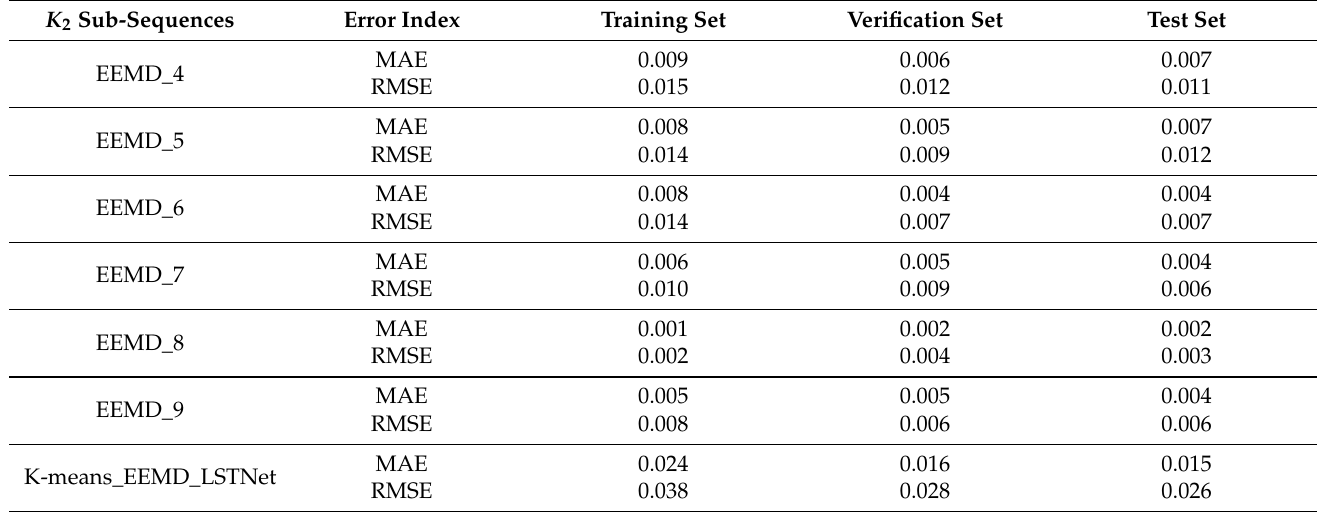
Figure 6. Results of model training. Blue is the original data, yellow is the training set, green is the verification set and red is the test set. Table 3. The evaluation indexes of model training for load forecasting.